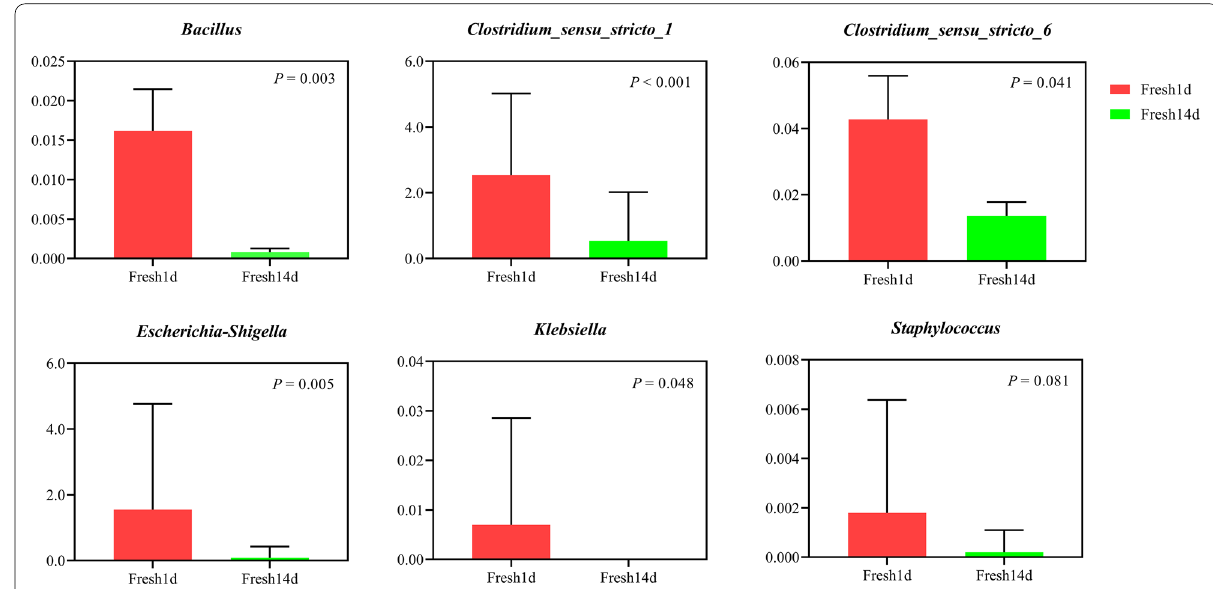
Fig. 3 The barplot of the relative abundance of potentially pathogenic bacteria in dairy cows during early lactation. Fresh1d indicates fecal microbiota samples from cows on d1, Fresh14d indicates fecal microbiota samples from cows on